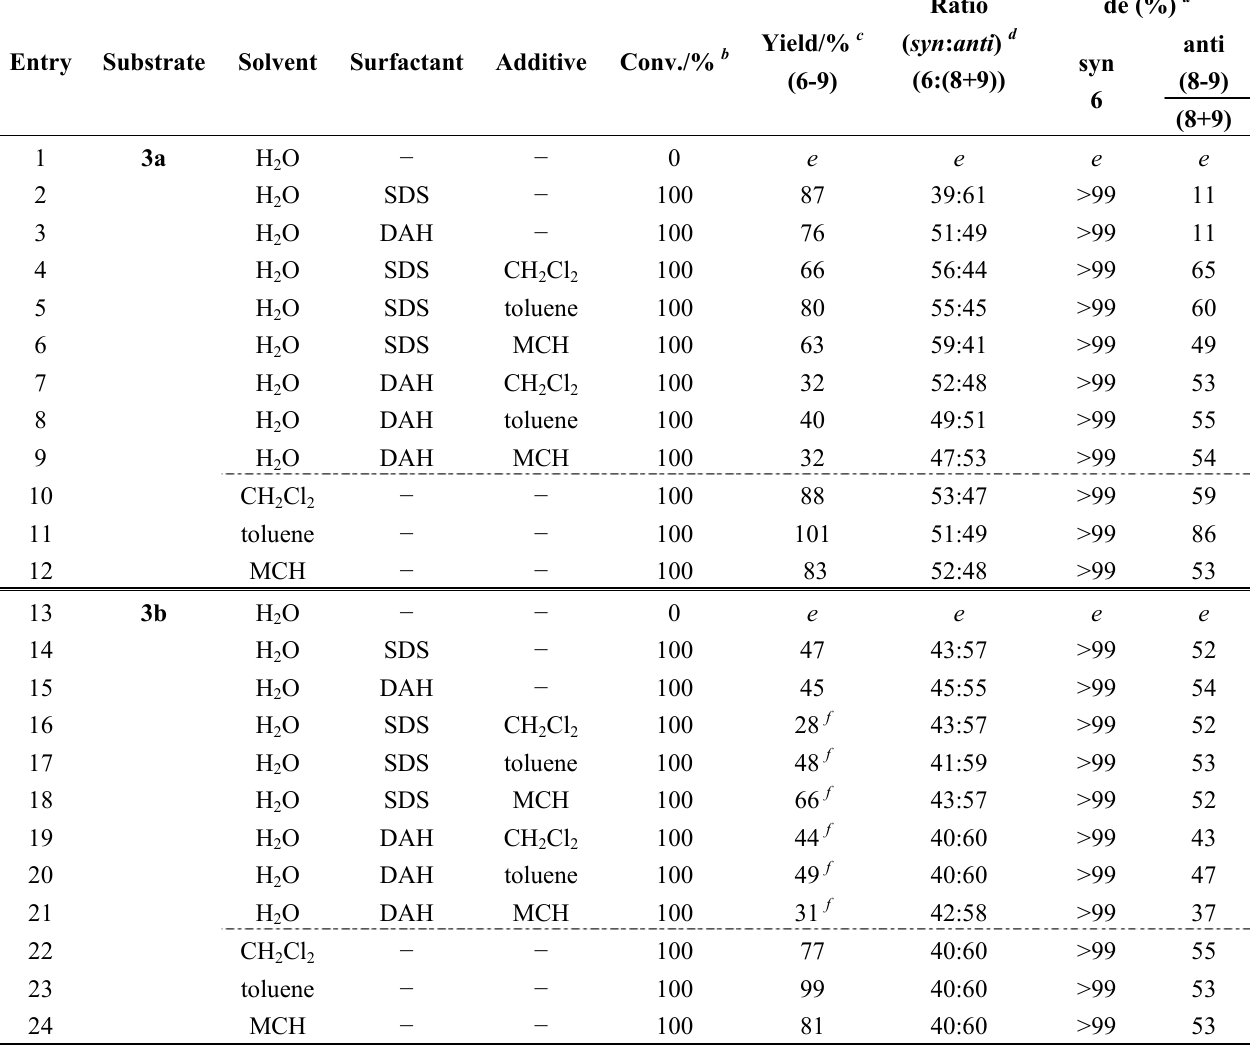
a Irradiated for 3 h at 0 °C. (See the Experimental Section.) b Determined by 1 H-NMR. c Determined by the weight. d Determined by HPLC (CHIRALPAK AD). e Not observed. f Isolated